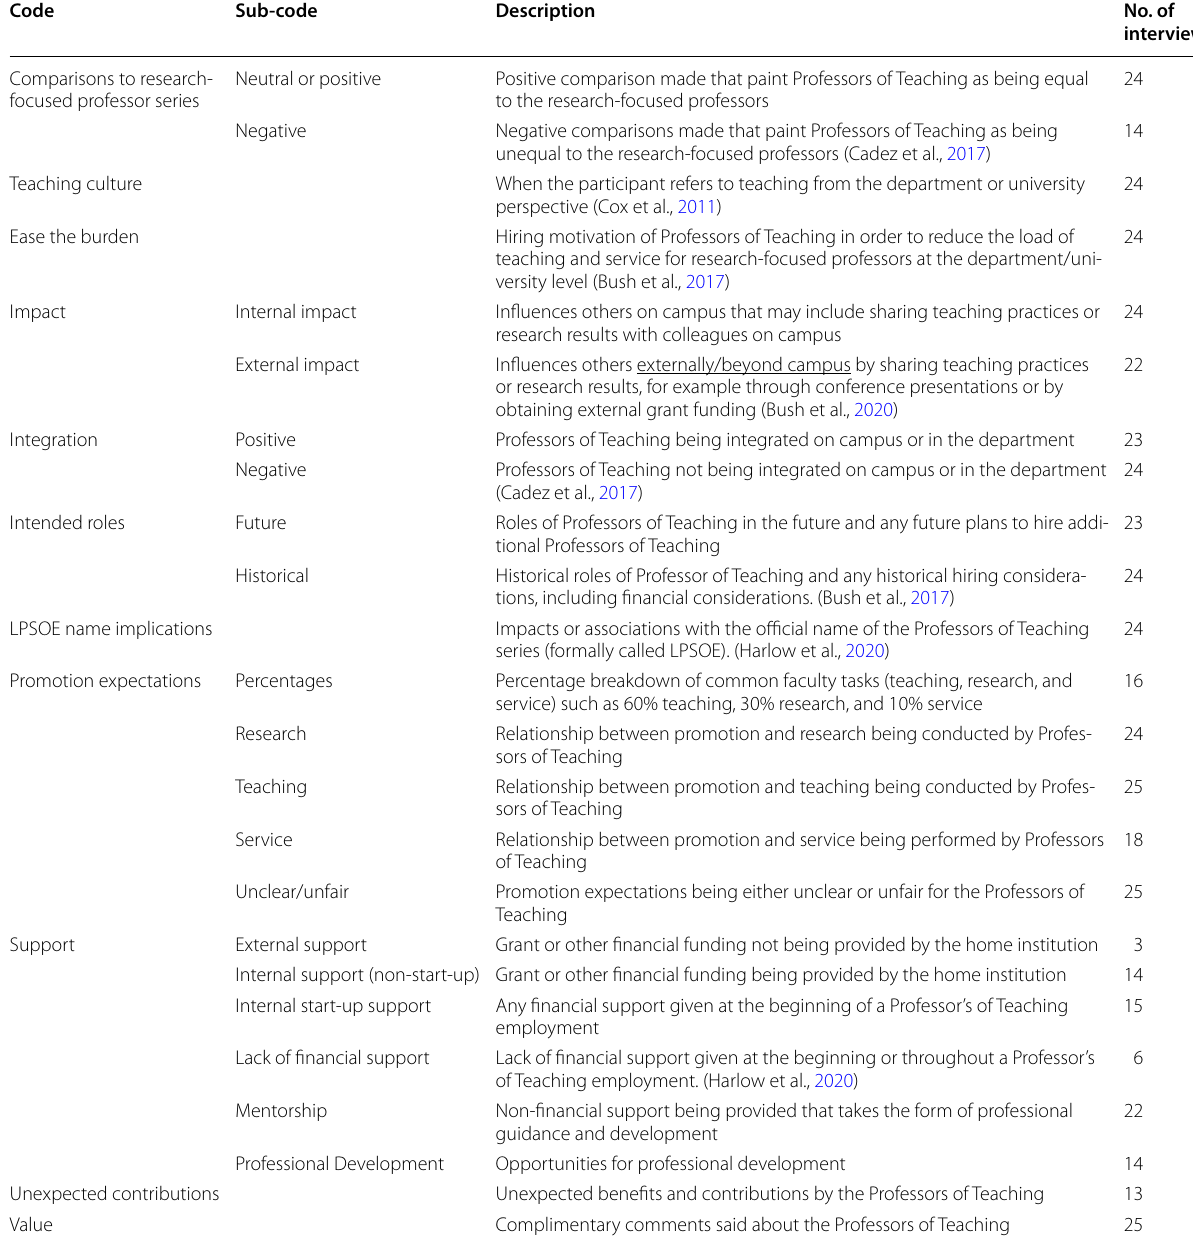
Table 1 Final codebook and code frequency for interview